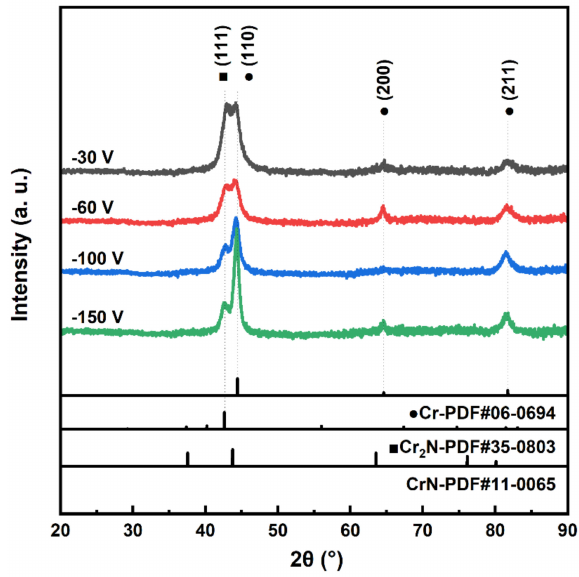
Figure 3. Effect of V s on crystalline phase.